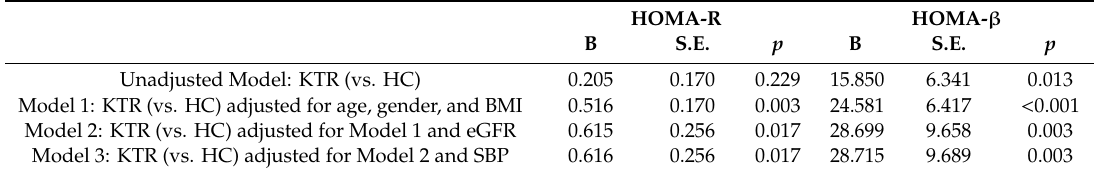
Table 5. Correlation between HOMA-R and HOMA- β with presence of kidney transplantation in adjusted linear regression analysis.